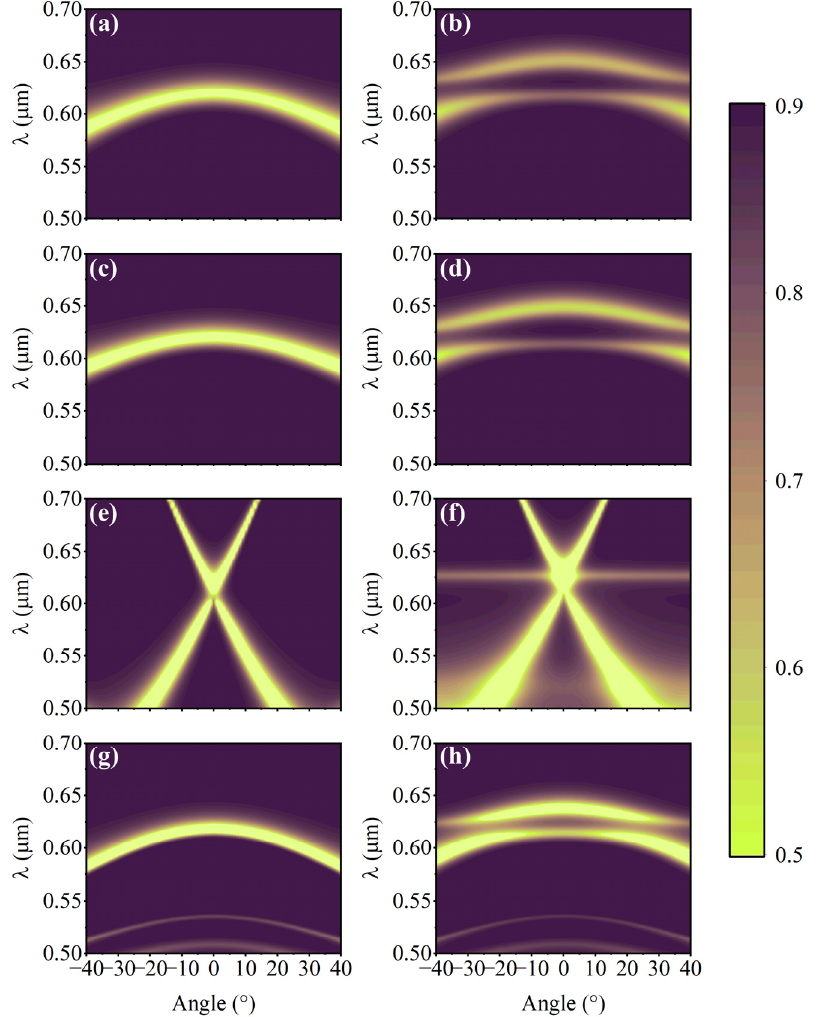
Figure 6. Compared results of angle-resolved reflectance spectra between the individual photonic cavities ( left ) and the cavity-ML WS 2 -integrated heterostructures. ( a – h ) From top to bottom, the panels represent the categories of S1 ( a , b ), S2 ( c , d ), S3 ( e , f ), and S4 ( g , h ), respectively.